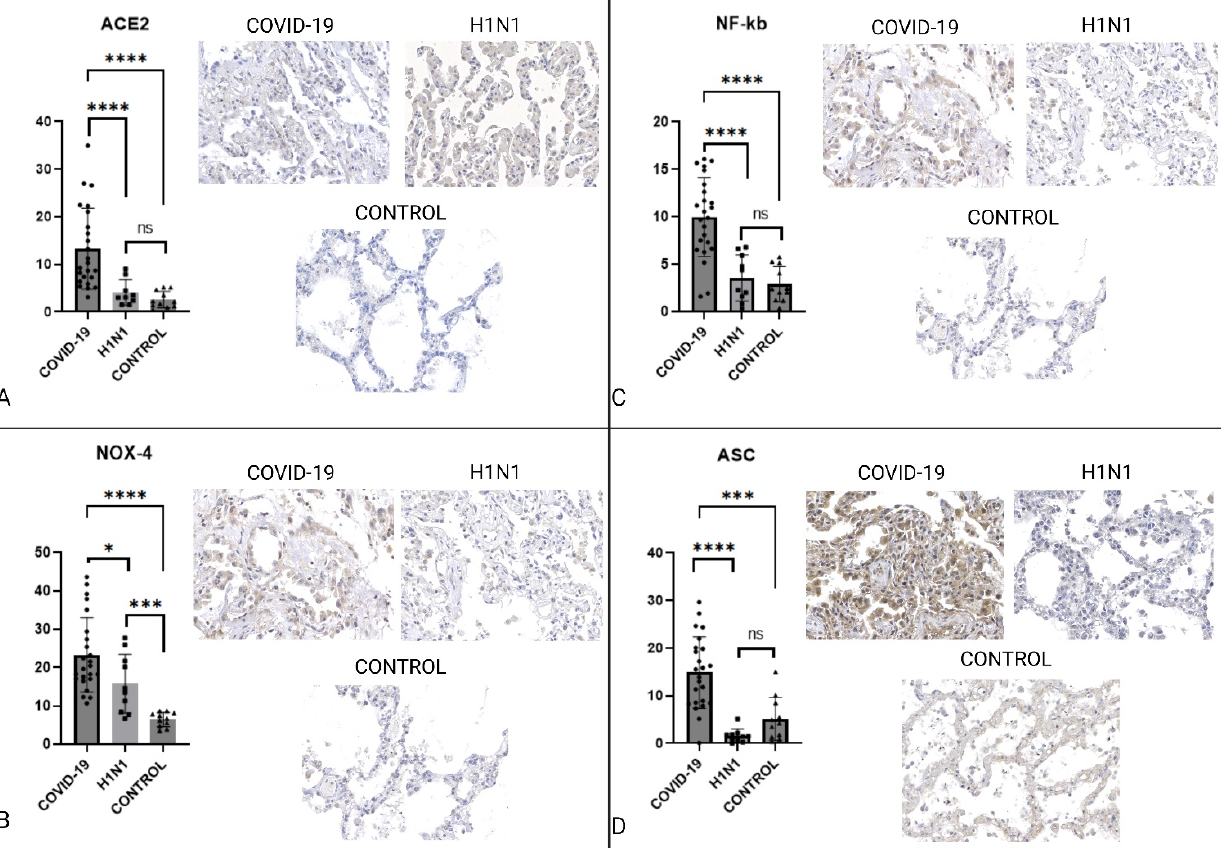
Figure 1. Graphs showing the comparison between COVID-19, H1N1, and CONTROL groups concerning ACE2, NOX4, NF- κ B, and ASC. Panel ( A ) shows that ACE2 is significantly increased in COVID-19 when compared to H1N1 and the control group. In Panel ( B ), NOX4 is more expressed in COVID-19 than in the H1N1 and CONTROL groups. Images ( C ) and ( D ) also show that NF- κ B. and ASC expression are remarkably high in COVID-19. These graphs show that the COVID-19 expressed characteristics needed for SARS-CoV-2 cell entry as well as oxidative stress and key components for inflammasome activity. The symbol “ * ” stands for p ≤ 0.05, “ *** “ stands for p ≤ 0.001, “****” stands for p ≤ 0.0001. Slide images were obtained on a 40 × augmentation. Image created using